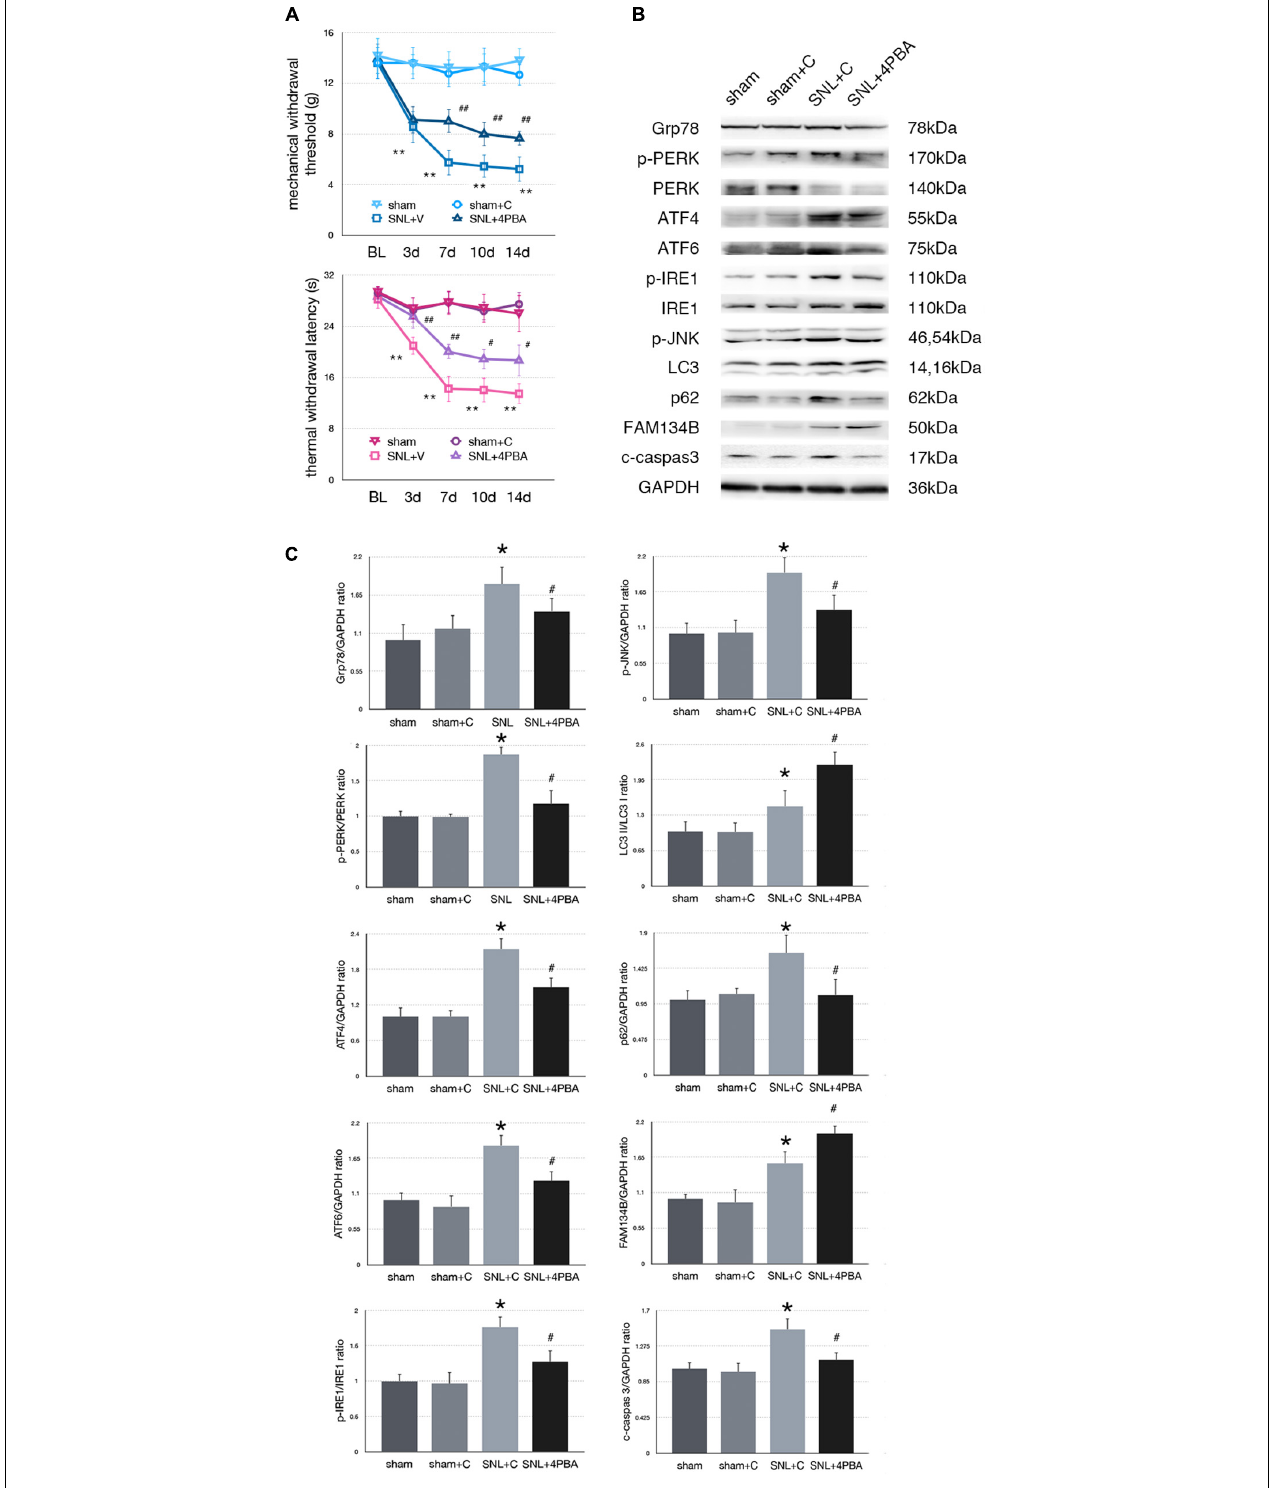
FIGURE 3 | Effect of 4-PBA on pain-related behavior tests and protein expression. (A) TWL and MWT in sham, sham + C, SNL + C, and SNL + 4-PBA. (B) Representative immunoblots of related protein expression are shown. (C) Quantifications of Western blot in sham, sham + C, SNL + C, and SNL + 4-PBA groups. 4-PBA leads to alleviate ER stress and induces ER-phagy increase in spinal cord. Data are presented as mean ± SD, n = 6 rats per group. sham vs. sham + C have no significant difference; * p < 0.05 SNL + C group vs. sham + C group; # p < 0.05 SNL + 4-PBA vs. SNL + C group. In behavior tests, ** p < 0.01, ## p < 0.01.